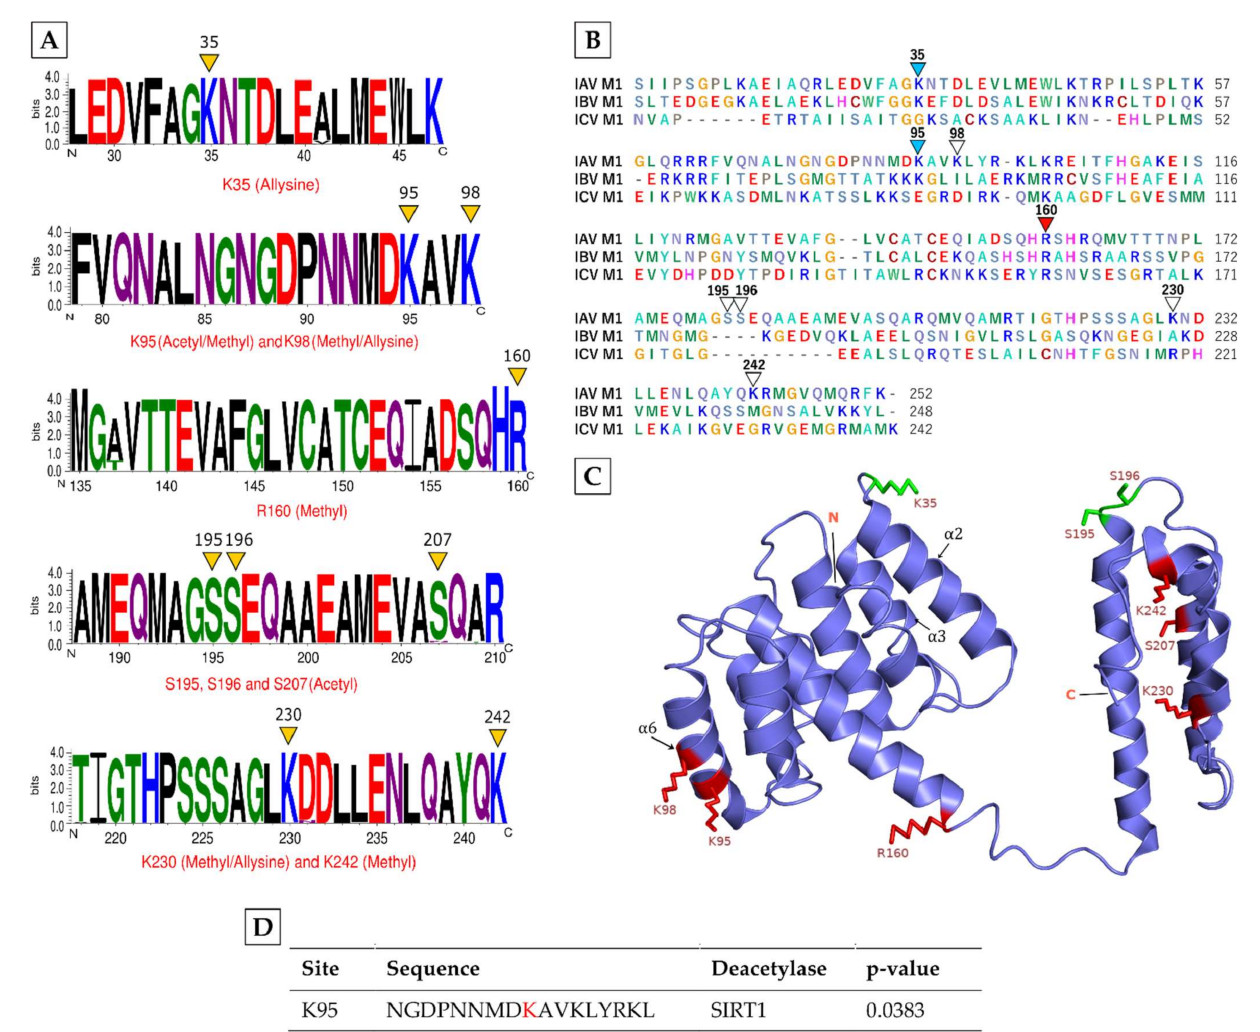
Figure 1. The characteristics of the modifications on IAV M1 protein. ( A ) Conservation of modified residues across M1 of IAV subtypes. A total of 800 sequences from 39 different IAV subtype strains were aligned in BioEdit using ClustalW and visualised by WebLogo. The logos represent the individual peptides with modified residues (yellow arrowheads). The X -axis indicates the position of amino acid and the Y -axis indicates the bit score on a scale of 1–4 (A scale of 4 means 100% conservation). Acetyl: acetylation, Methyl: methylation. ( B ) Conservation of modified residues across M1 of IAV, influenza B virus (IBV), and influenza C virus (ICV). The M1 sequences from IAV, IBV, and ICV reference sequences were aligned as above. Red arrowheads point to the conservation of modified residue in all three influenza virus types, turquoise arrowheads point to conservation in IAV and IBV, and white arrowheads point to no conservation. ( C ) Location of modified residues in the M1 structure. Red atom stick indicates the location on α -helix regions, green atom stick indicates the location on loop regions. N, N-terminal domain; C, C-terminal domain. ( D ) Prediction of identified acetylated sites (in red) to be acetylated or deacetylated by ASEB web